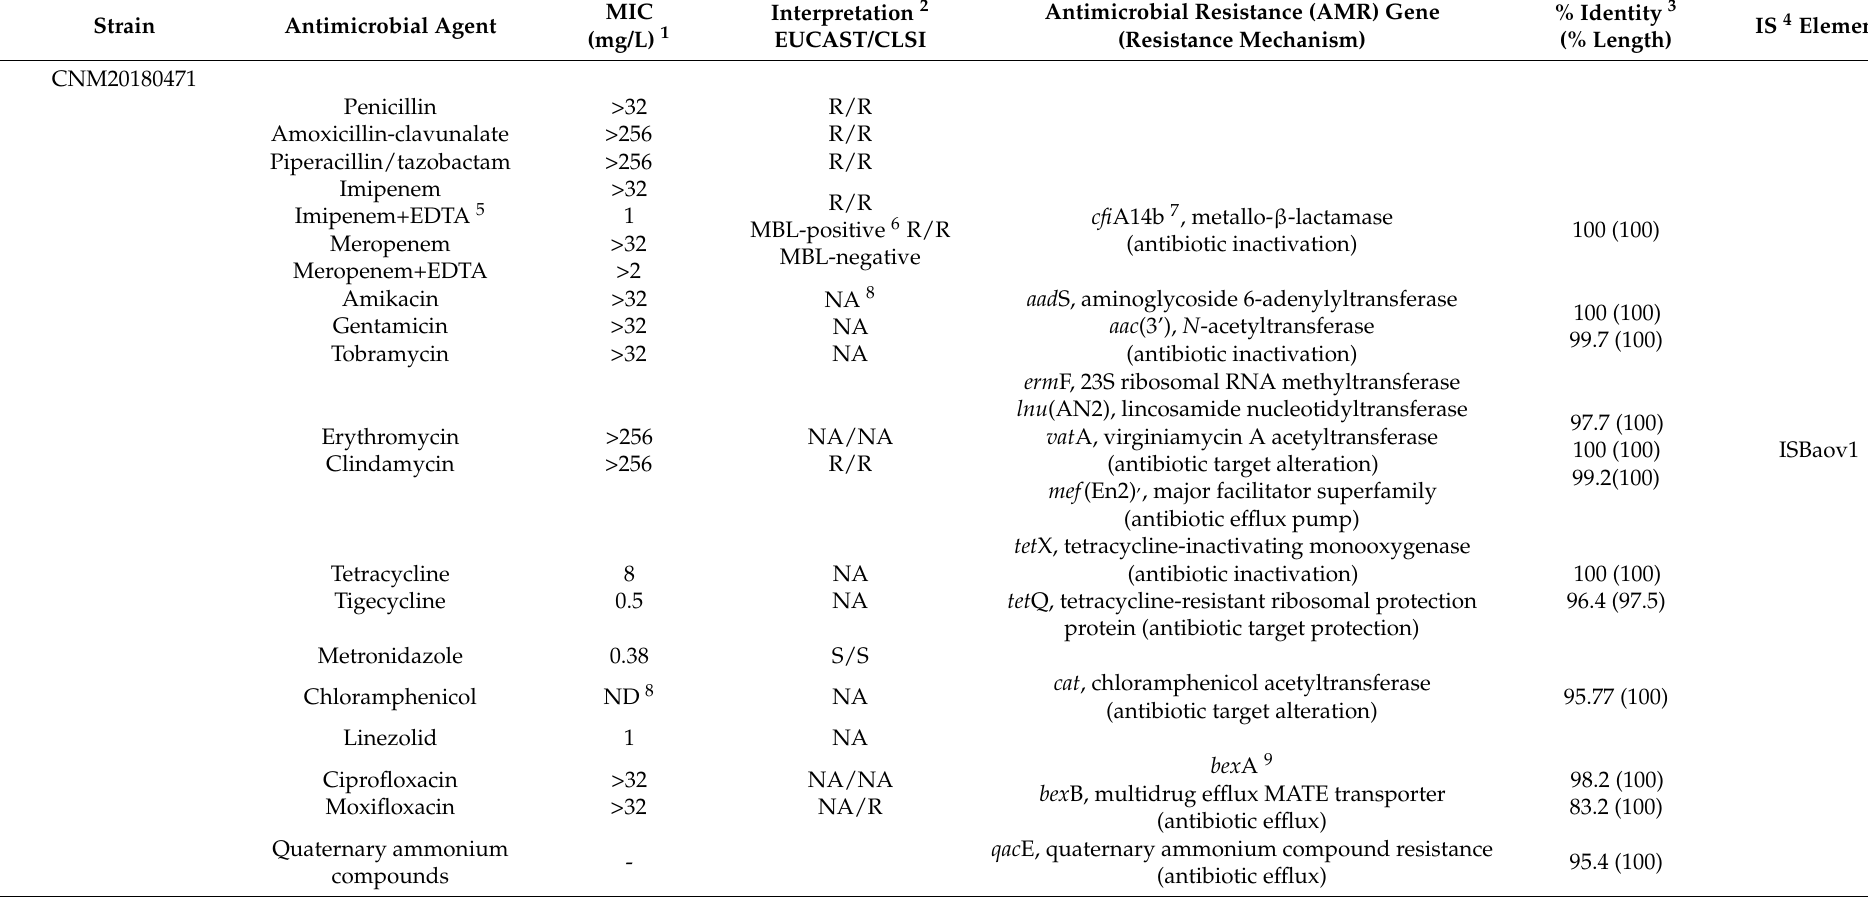
Table 1. Antimicrobial susceptibility, resistant genes, and IS elements identified in the two cfi A-positive B. fragilis strains resistant to